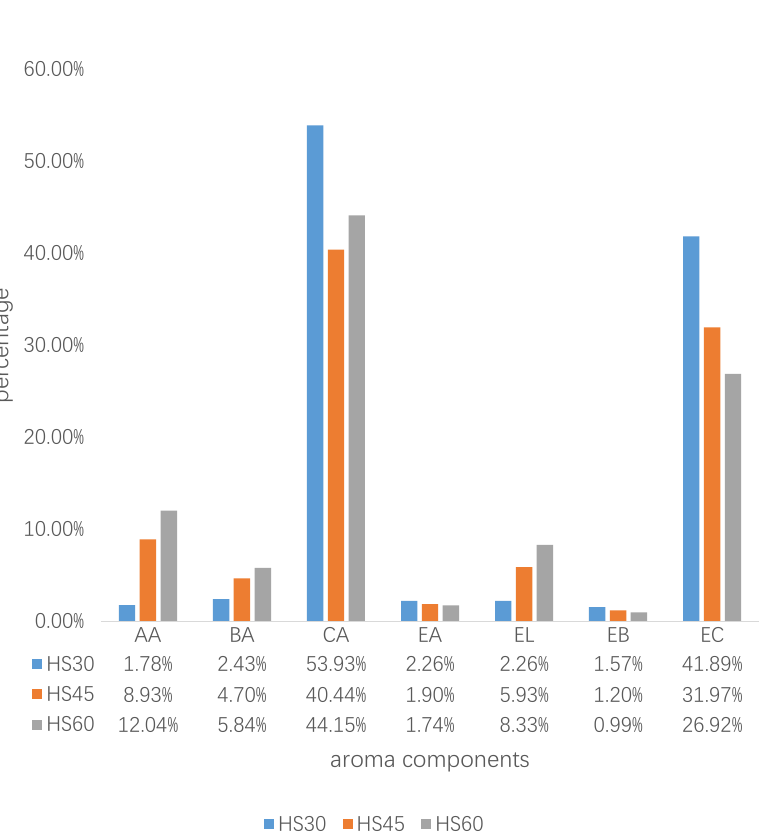
Figure 1. Percentage of aroma components at different fermentation times. AA: acetic acid, BA: butyric acid, CA: caproic acid, EA: ethyl acetate, EL: ethyl lactate, EB: ethyl butyrate, EC: ethyl caproate. HS30, yellow water at 30th day, HS45, yellow water at 45th day, HS60, yellow water at 60th day.